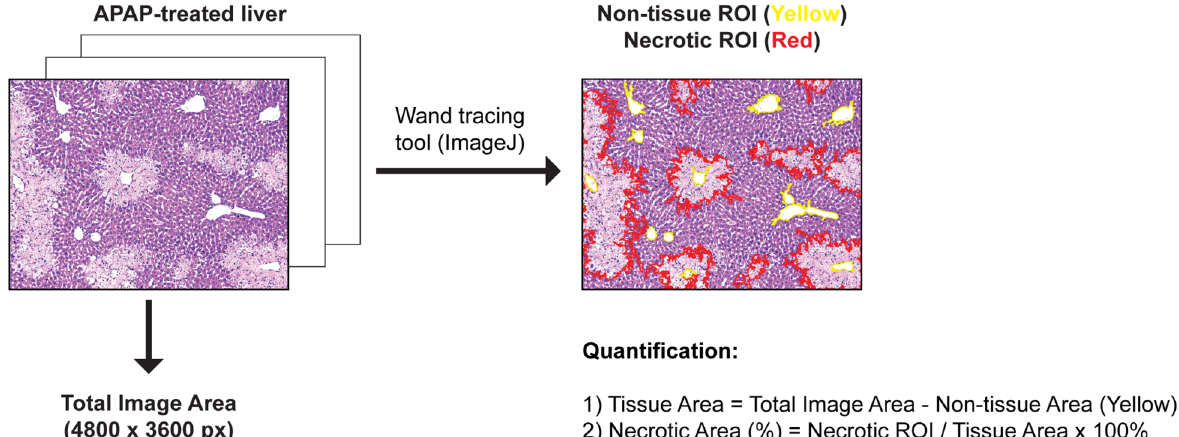
Figure 7. Exemplifies the quantification analysis.